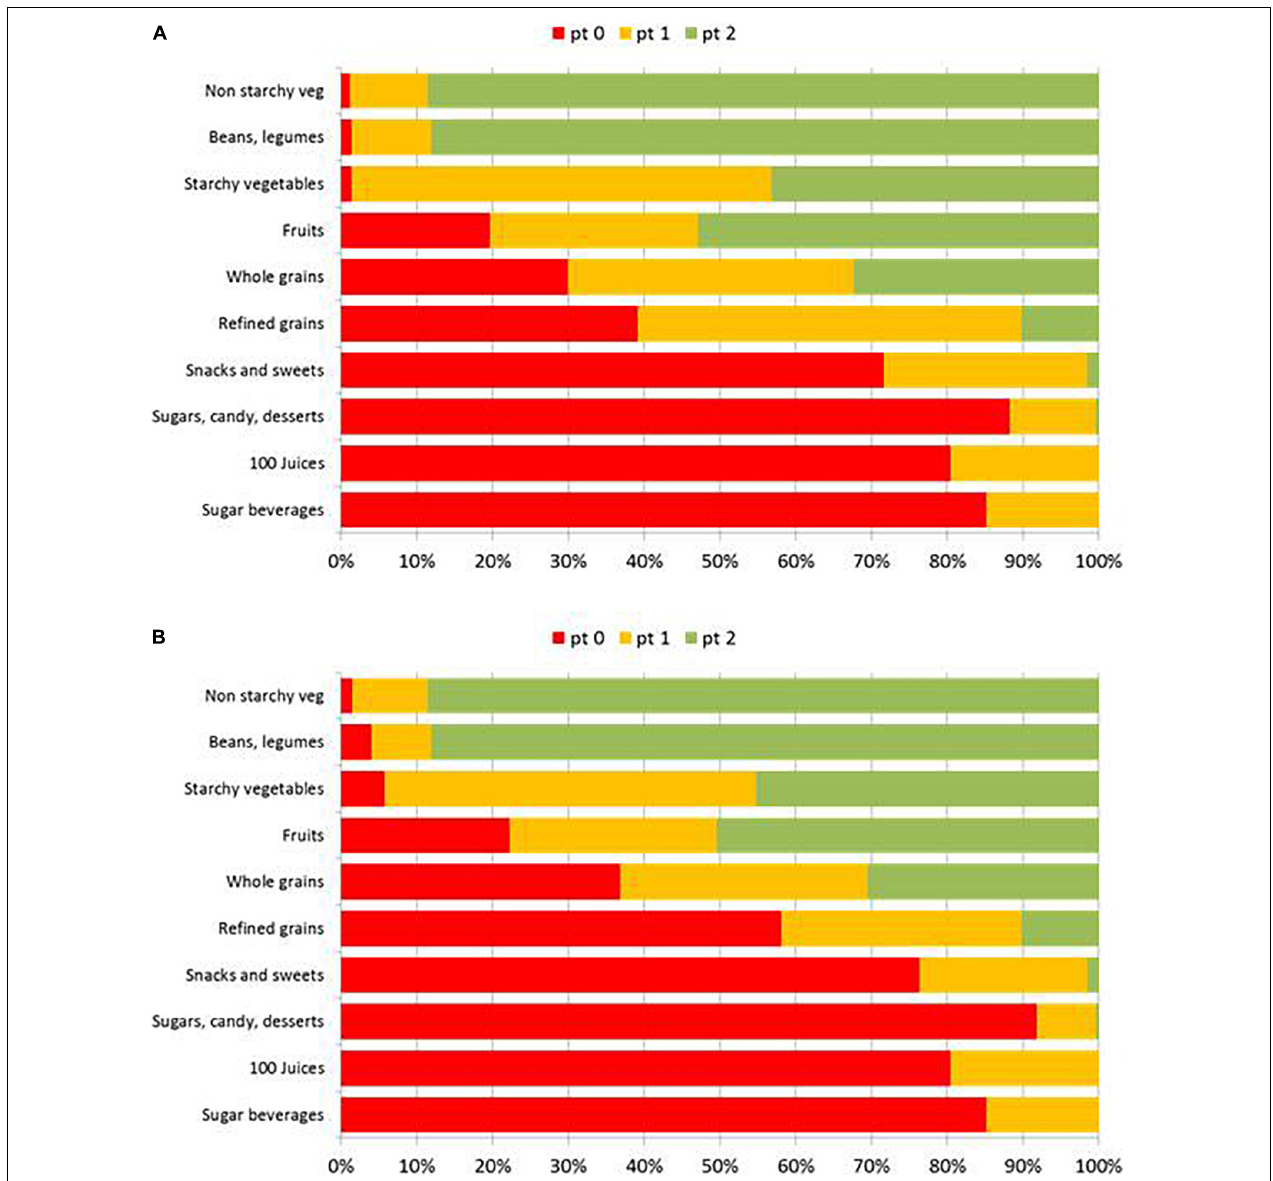
FIGURE 3 | Distribution of points scores for the 10:1:1 model (A) and the 10:1|2:1 model by (B) WWEIA food subgroup.